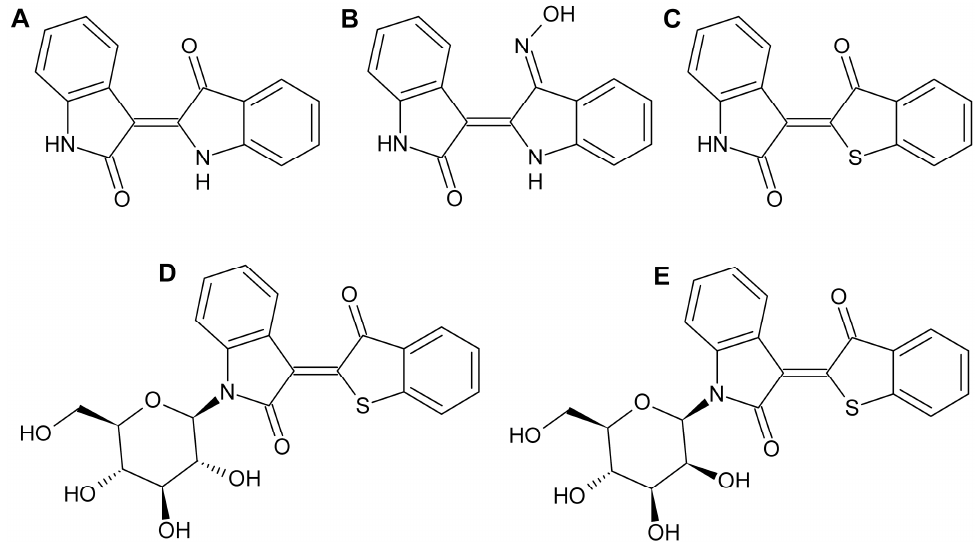
Figure 1. Chemical structures of indirubin (( A ), internal standard), indirubin-3 ′ -monoxime (( B ), I3M), KD88 (( C ), 3-[3 ′ -oxo-benzo[ b ]thiophene-2 ′ -( Z )-ylidene]-oxindole; non-glycosylated indirubin thia-analogue), KD87 (( D ), 3-[3 ′ -oxo-benzo[ b ]thiophen-2 ′ -( Z )-ylidene]-1-( β - D -glucopyranosyl)-oxindole; thia-analogous indirubin N -glycoside with glucose as sugar component), and KD85 (( E ), 3-[3 ′ -oxo-benzo[ b ]thiophene-2 ′ -( Z )-ylidene]-1-( β - D -mannopyranosyl)-oxindole; thia-analogous indirubin N -glycoside with mannose as sugar component).